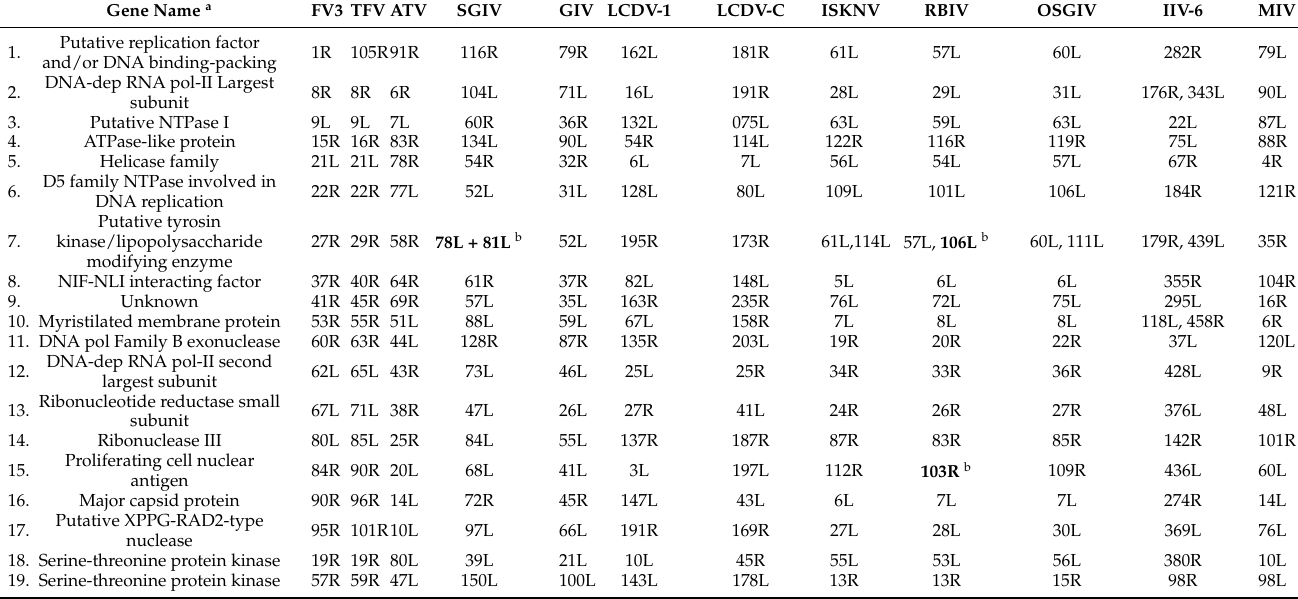
Table 1. Iridovirus core genes.